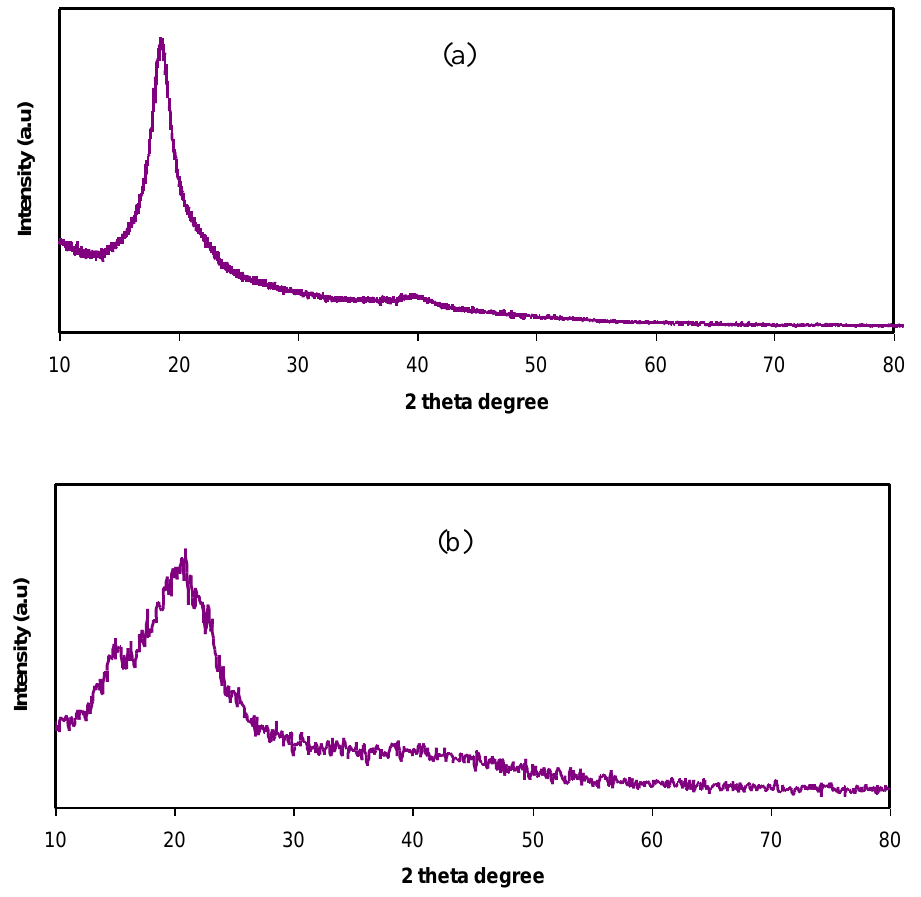
Figure 1. XRD pattern for ( a ) pure poly(vinyl alcohol) (PVA) and ( b ) pure chitosan (CS).